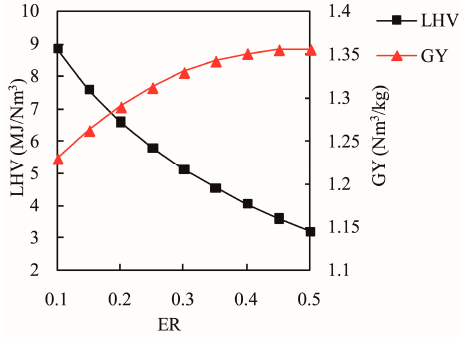
Figure 14. Effects of ER on LHV and GY at T = 1100 K and SBR = 0.5.